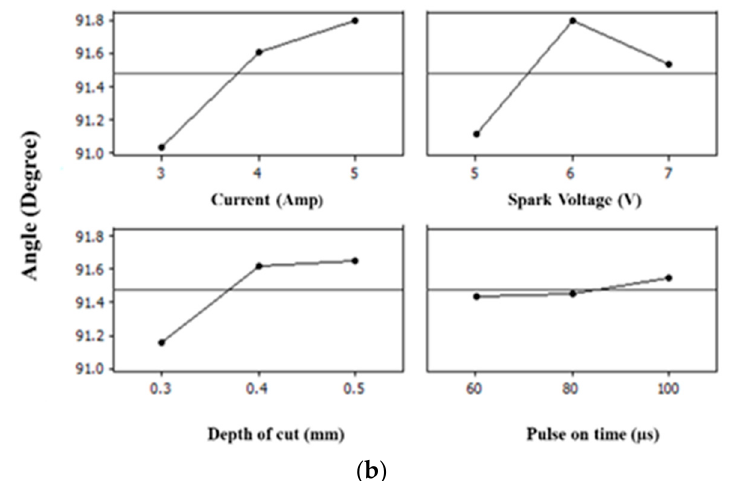
Figure 3. Main effect plots for accuracy of profile at different angles. Part ( a ) of Figure 3 shows the effect of all four input parameters on the accuracy at an angle of 60°, whereas ( b ) shows the effects of same parameters at an angle of 90°.